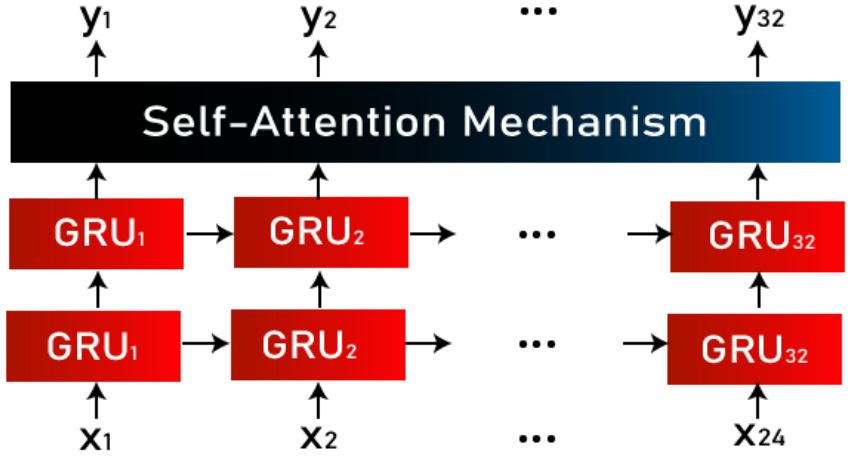
Figure 6. Connection of GRU with the attention